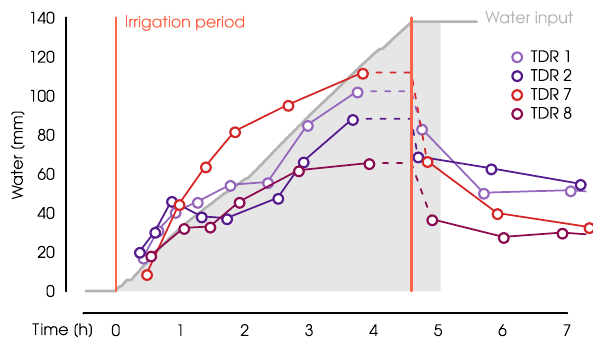
Figure 7. Water balance of the top 1.4m of the soil column for the four core area TDR profiles. Dashed lines indicate the storage increase at the last measurement before irrigation ended. The vari- ability between the four profiles shows the high heterogeneity and causes uncertainty regarding the average mass balance of the core